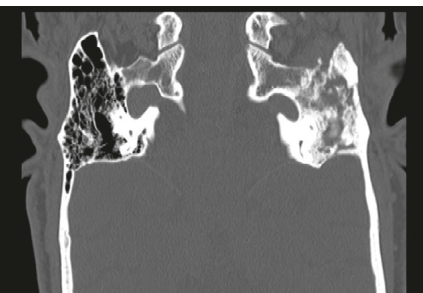
Figure 2: High-resolution CT scan (coronal cut) of the temporal bone. Total opacification of the left-sided hypo- and meso- tympanum by a soft tissue density. Mastoid air cells totally opa- cified with resorption of septae and partially sclerosed bone. Partial dehiscence of the mastoid portion of the facial nerve canal. The left tympanic membrane is thickened and retracted inwards. The left middle ear ossicles and scutum are intact. Normal aeration of the external auditory canals with intact bony and cartilaginous boundaries. The right middle ear cavity is normally aerated with intact ossicles. The right mastoid air cells are unremarkable.